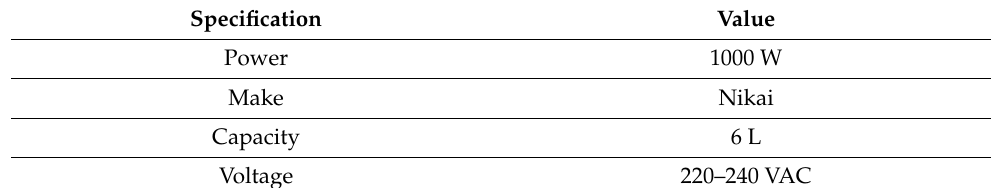
Table 2. EPC Specifications.